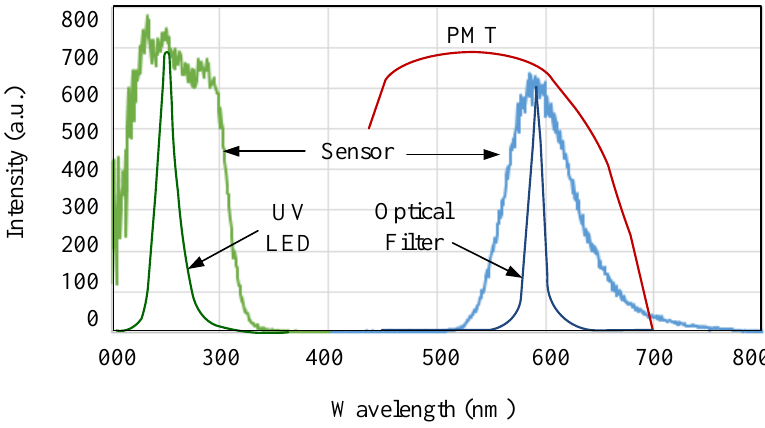
Figure 3. Spectral response of the chemical sensor, LED, optical filter, and photomultiplier tube (PMT).